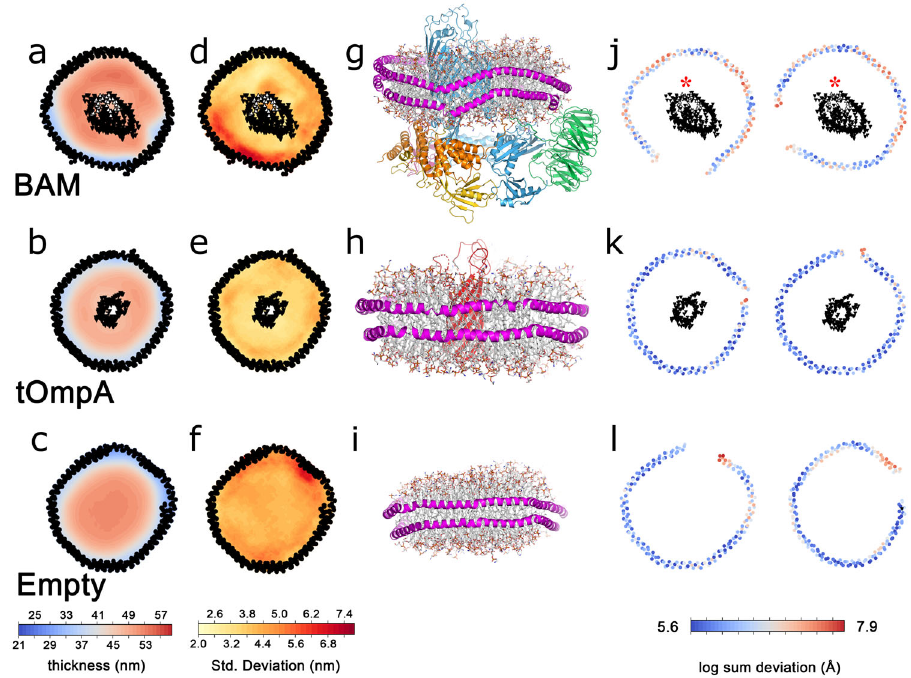
Fig. 4 Molecular dynamics simulations of protein-containing and empty lipid nanodiscs. Mean thickness of lipid bilayers over the course of a 1- µ s simulation for BAM-containing ( a ), tOmpA-containing ( b ) or empty ( c ) MSP1D1 nanodiscs. The standard deviation of bilayer thickness over the 1- μ s simulation for BAM-containing ( d ), tOmpA-containing ( e ) or empty ( f ) MSP1D1 nanodiscs. Residues in the lateral gate are indicated in white. The 3D structures of the fi nal frame of each simulation, coloured as in Fig. 1, with the MSP in magenta for BAM-containing ( g ), tOmpA-containing ( h ) or empty ( i ) MSP1D1 nanodiscs. Deviation from planarity for the upper (left) and lower (right) MSP in BAM-containing ( j ), tOmpA-containing ( k ) or empty ( l ) MSP1D1 nanodiscs. In a , b , d , e , j and k the mean positions of the α -carbons of the MSPs and β -barrels of the inserted proteins are represented by black dots. Strands β 1 and β 16, which make up the lateral gate of BamA, are indicated with a red asterisk in ( j